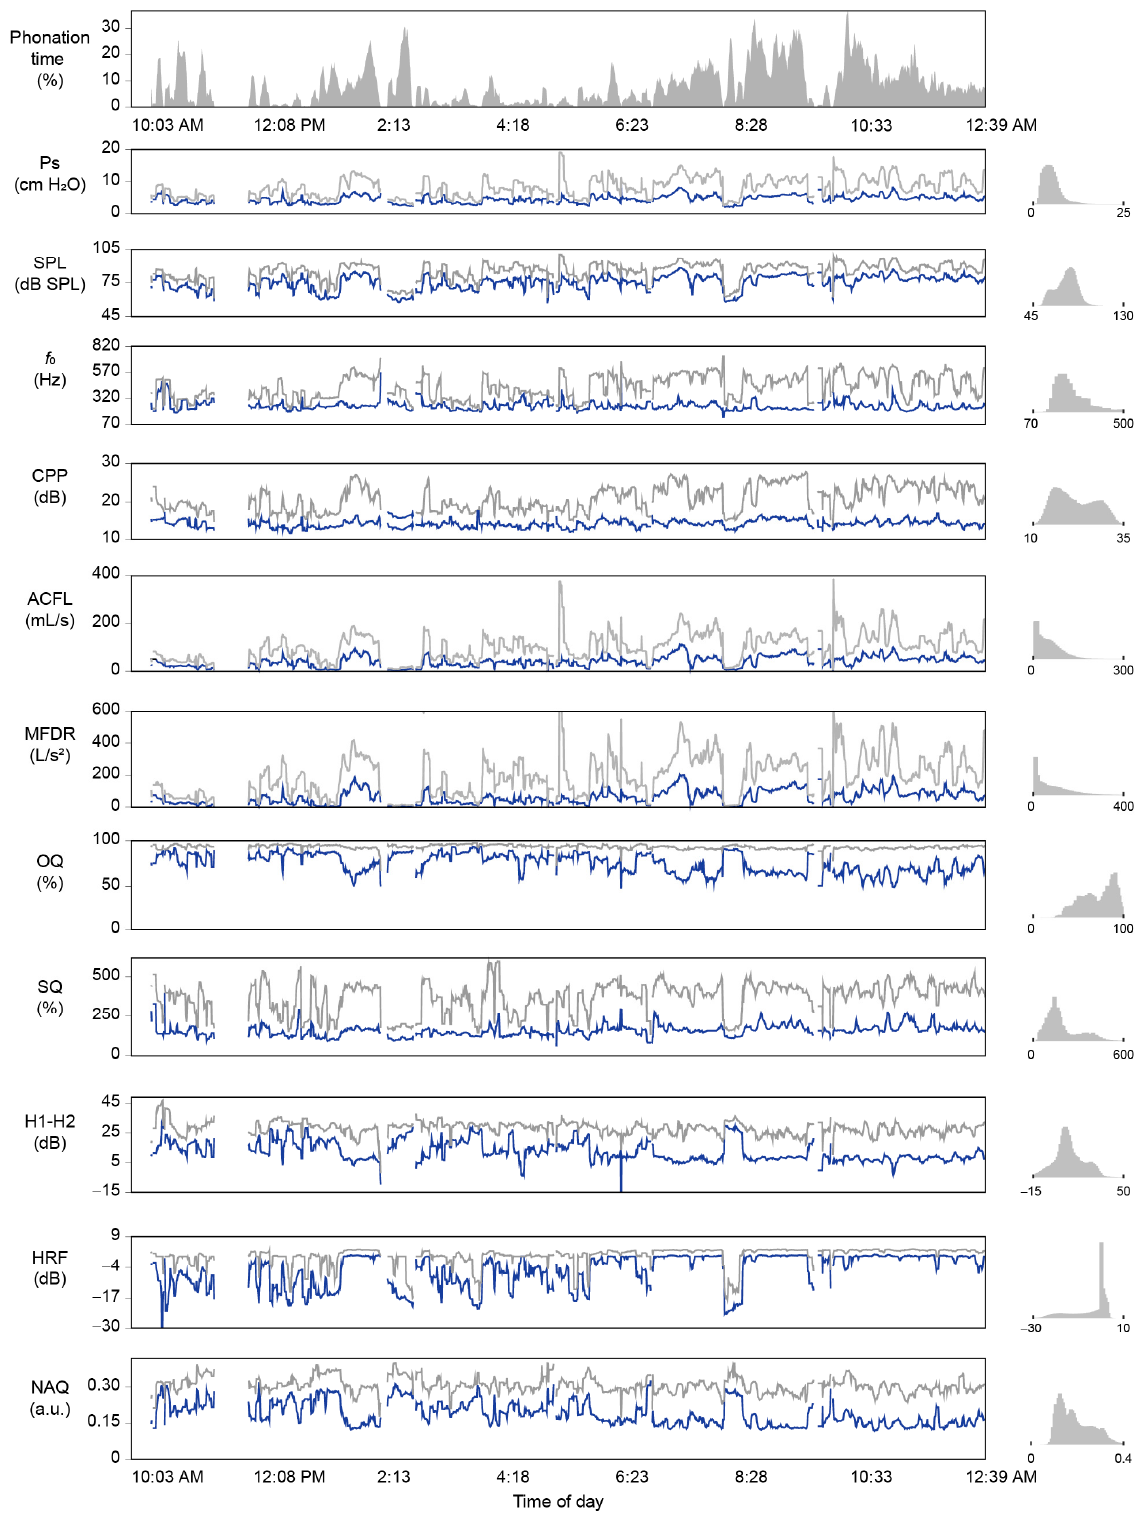
Figure 4. Illustration of the time-varying nature of daylong vocal function. The first plot shows the percent phonation computed over 5-min windows at intervals of half a minute. Subsequent plots are the 5-min moving averages of the median (blue line) and the 95th percentile (grey line) of the vocal function measure. Daylong histograms of each measure are shown to the right of each respective time series.